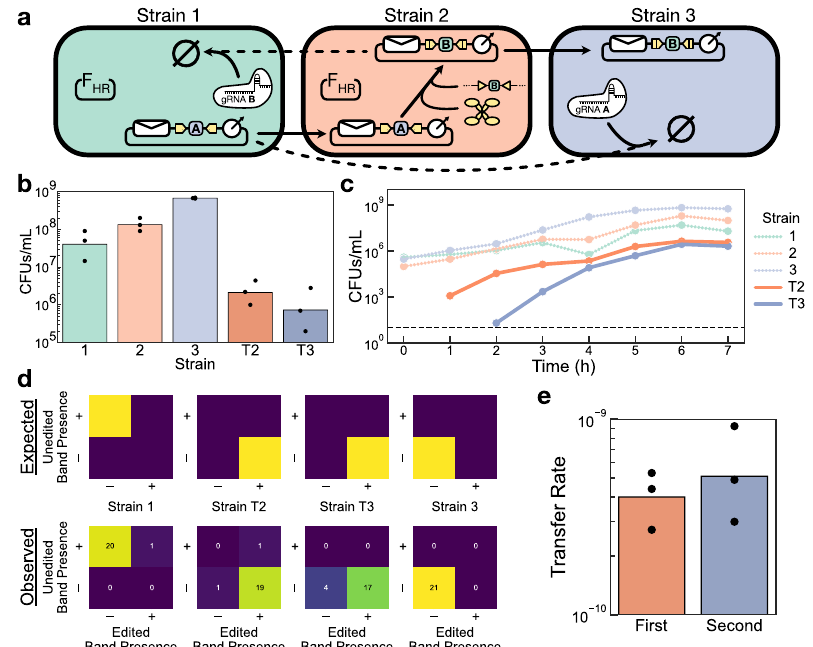
Fig. 6 | A three-strain linear message relay. a Schematic of the relay system. The messageplasmidstartsinStrain1andcanonlybetransferredtoStrain2.Whenthe messageentersStrain2,itsaddressiseditedsothatitcannolongerreturntoStrain 1 but is now allowed to continue on to Strain 3. This architecture is scalable to n strains (Supplementary Fig. 5). b Endpoint densities of each strain after 6h of coculture. c Timecourse plating of each strain within the coculture for a single biological replicate. The dashed black line marks the limit of detection. d PCR assaysofendpointcoloniesfromselectedstrains.(Toprow)Theexpectedplasmid